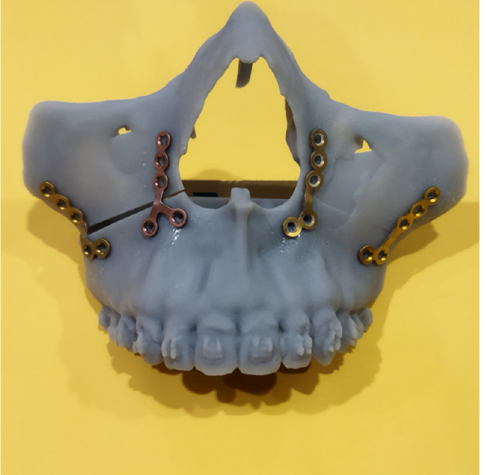
Figure 2. The intraoperative fixation plates were prebent on a 3D-printed stereolithographic model of actual anatomical size. The precise matching of the screw holes and fixation plates provided guidance for the intraoperative jawbone repositioning and orientation.